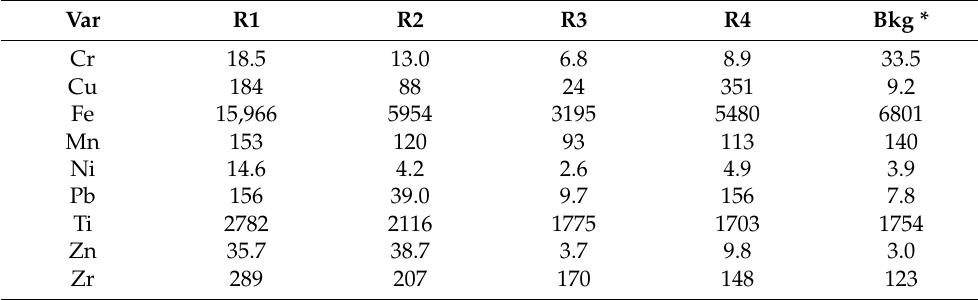
Table 2. Rhizosphere soil samples and potentially toxic elements content of background soils (Bkg) (in mg/kg).